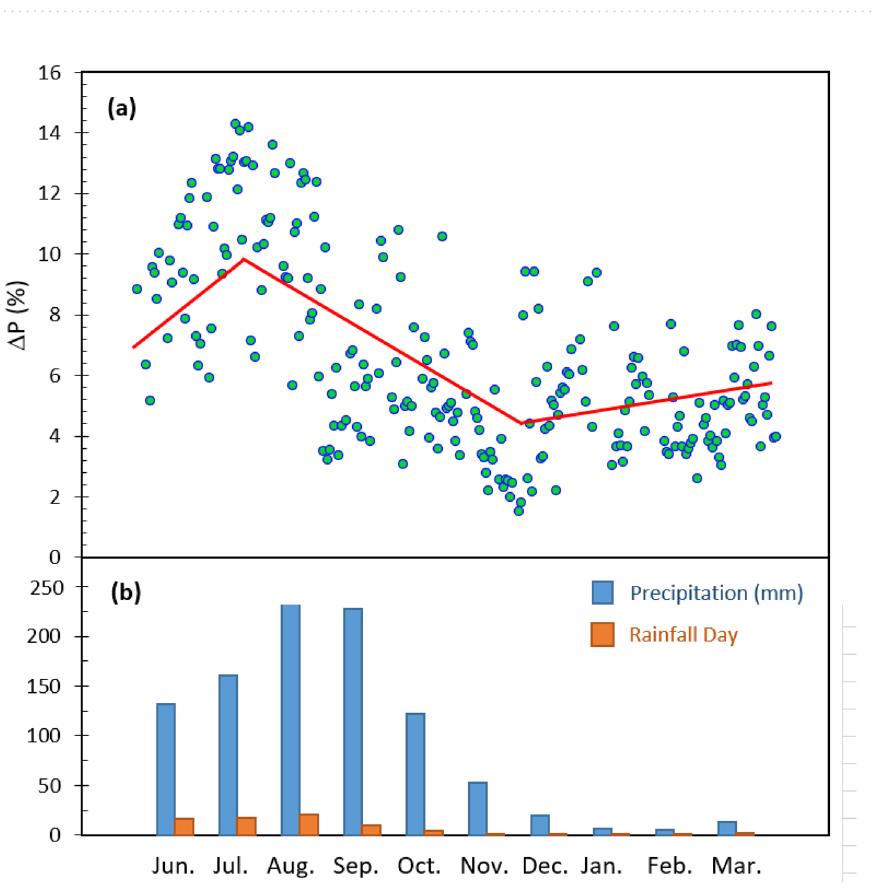
Figure 13. ( a ) The differences in the average daily output power ( b ) precipitation and rain fall days in the experimental